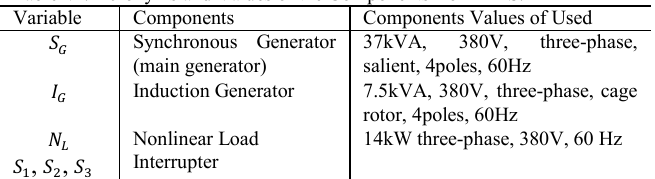
Table VI. Acronyms and Values of the Components from IEPS. Variable